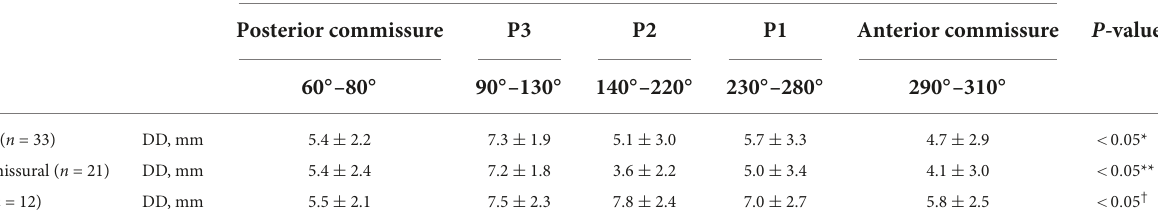
TABLE 2 Regional values of disjunction.